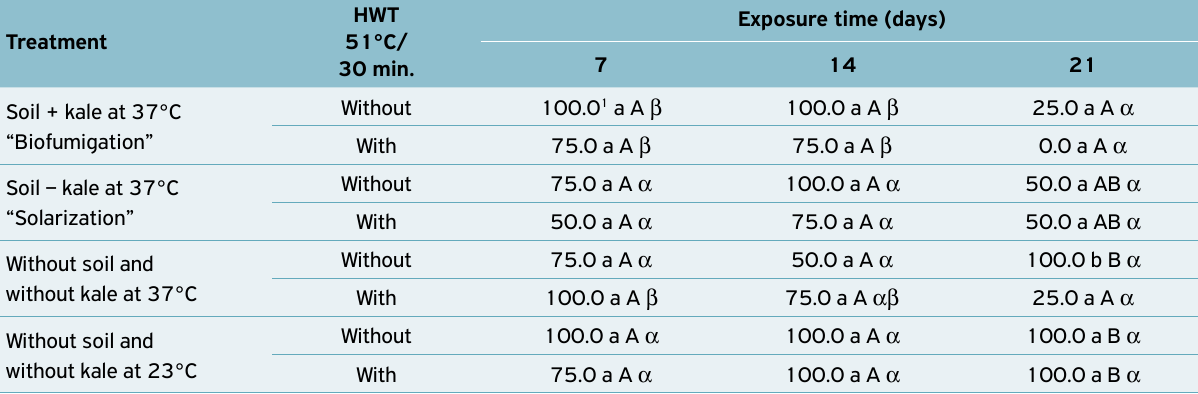
Table 5. Percentage of root formation in the rootstock IAC 766 cuttings submitted to disinfection in different periods, with and without added hot-water treatment